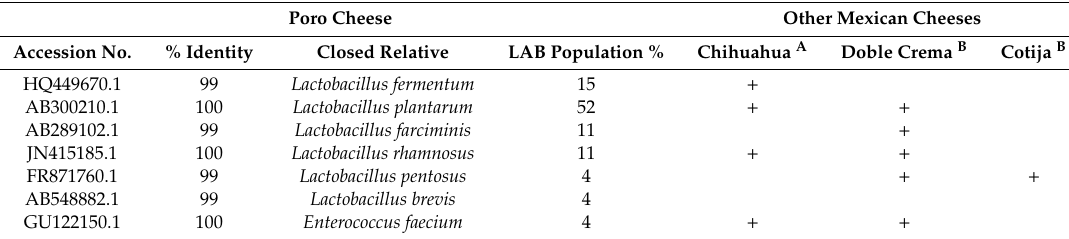
Figure 6. PCR-TTGE analysis of V3 16S rRNA fragments from Poro cheese samples, from 2 productions QP1 and QP3. Table 5. Main identified lactic acid bacteria of Poro cheese.